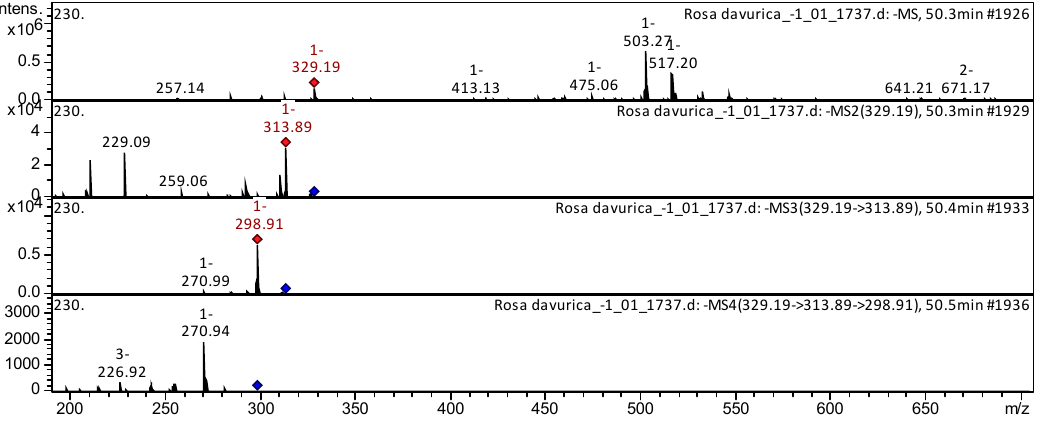
Figure 5. CID-spectrum of Nevadensin from extracts of R. acicularis , m / z 346.86. The [M + H] + ion produced two fragment ions at m / z 330 and m / z 212 (Figure 5). The fragment ion with m / z 330 yielded one daughter ion at m / z 314. The fragment ion with m / z 314 yielded five daughter ions at m / z 312, m / z 286, m / z 259, m / z 182, and m / z 133. It was identified in the bibliography in extracts of Ocimum [19] and Mentha [26]. 3.3. Trihydroxyflavones The flavones Apigenin (compound 2 ), Chrysoeriol (compound 3 ), Isovitexin (com- pound 16 ), and flavonol Isokaempferide (compound 22 ) have been already characterized as components of Mentha [26], Hedyotis diffusa [27], Andean blueberry [28], Stevia rebaudiana [29], Rosa rugosa [30], Propolis [31], Rhus coriaria [32], Mexican lupine species [33], etc.